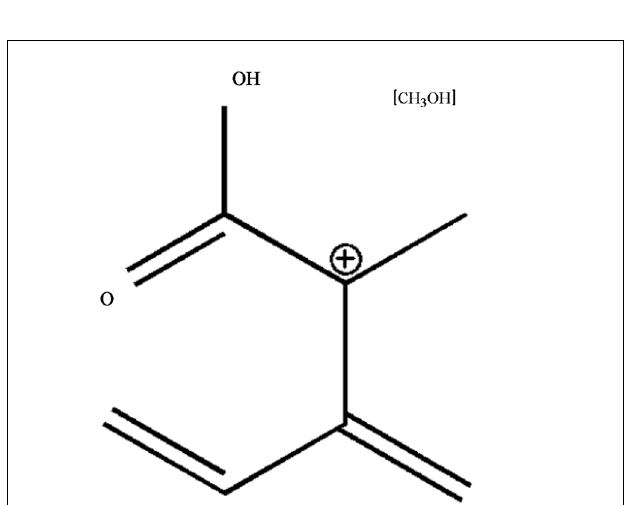
FIGURE 6 | Effect of contact time on degradation rate and degradation capacity of PPL for patulin.